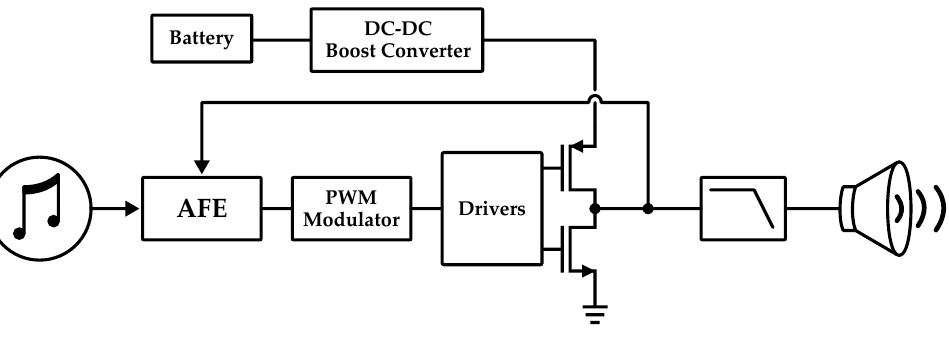
Figure 17. Schematic representation of a standard class D amplifier for audio